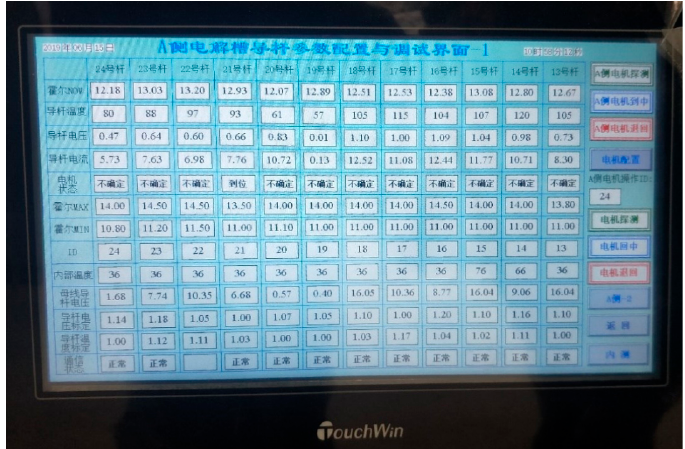
Figure 8. Data acquisition display diagram of anode current measuring device.